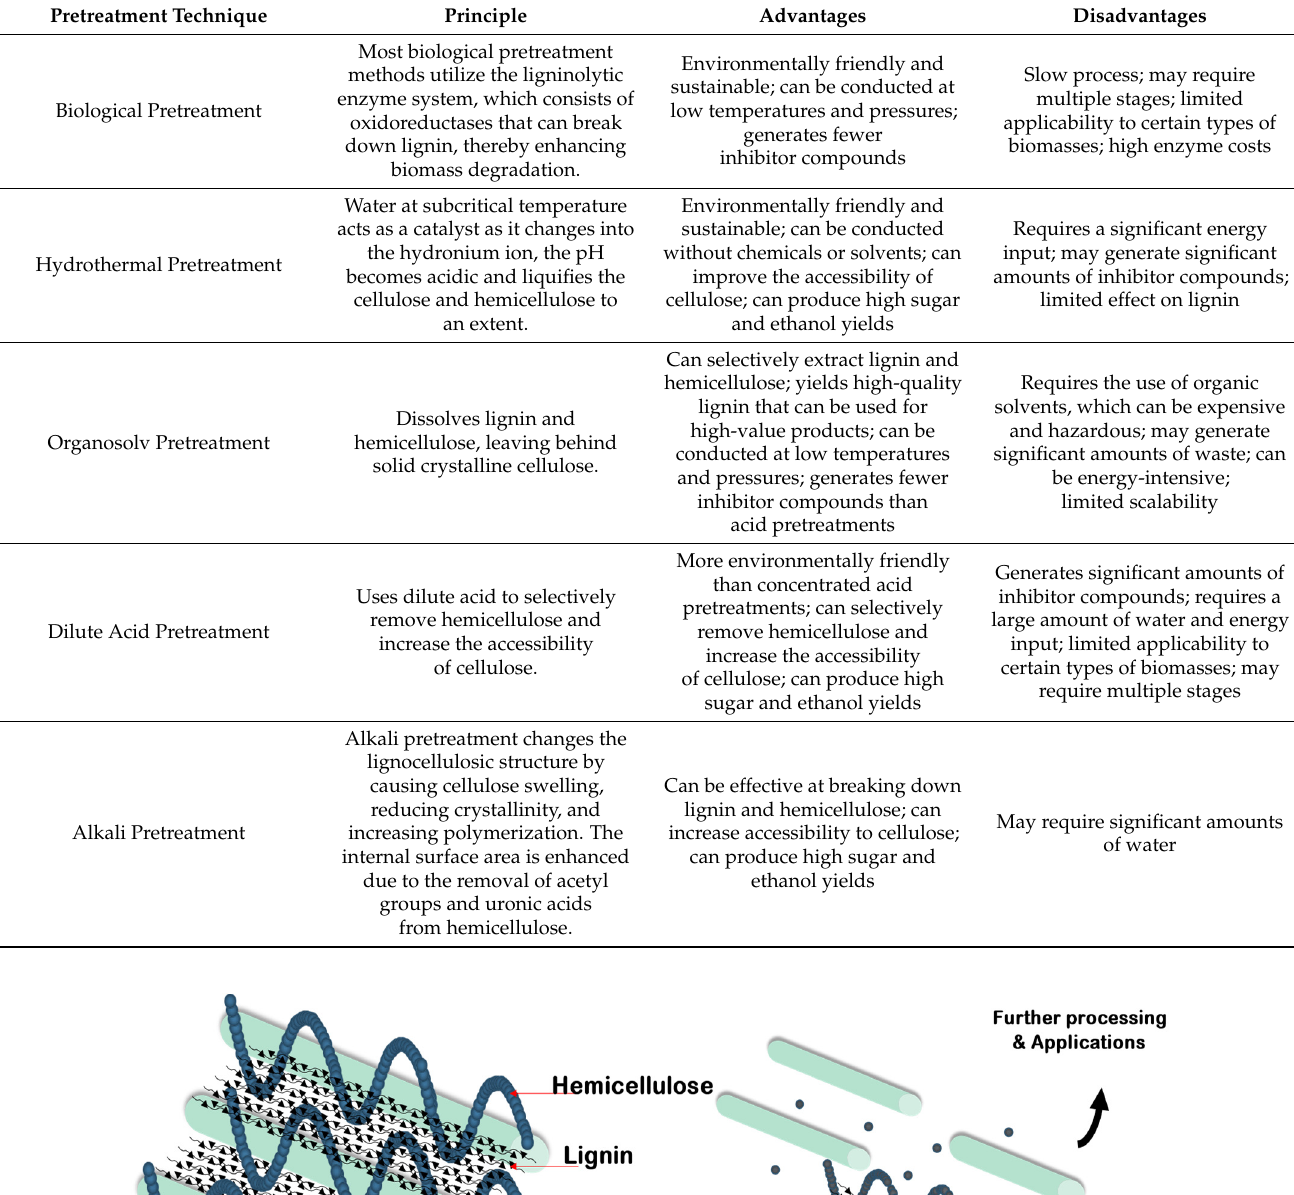
Table 1. Table showing different pretreatment techniques and their advantages and disadvantages.